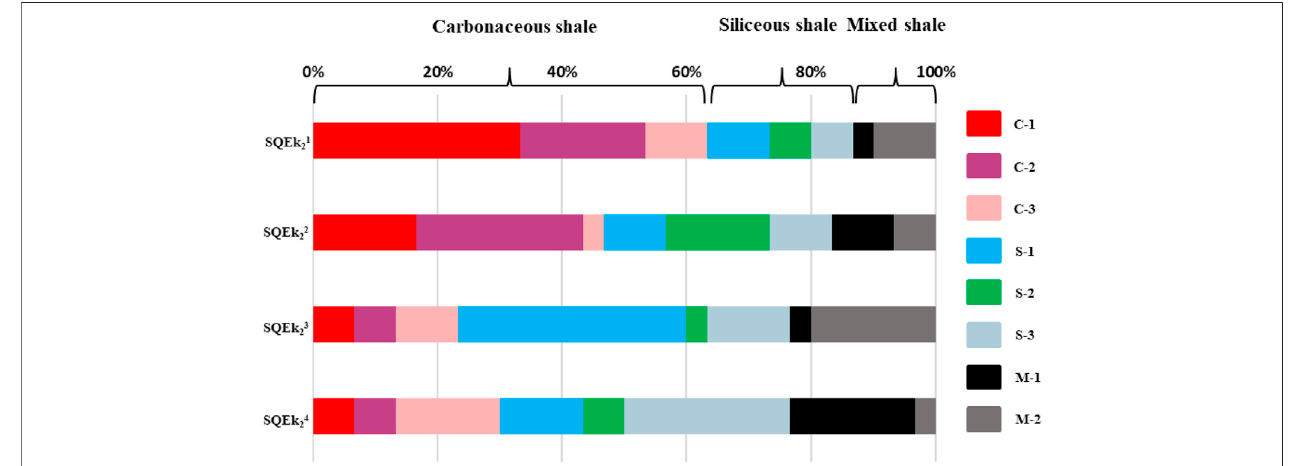
FIGURE 10 | Statistics of lithofacies distribution thickness in different sub-members.